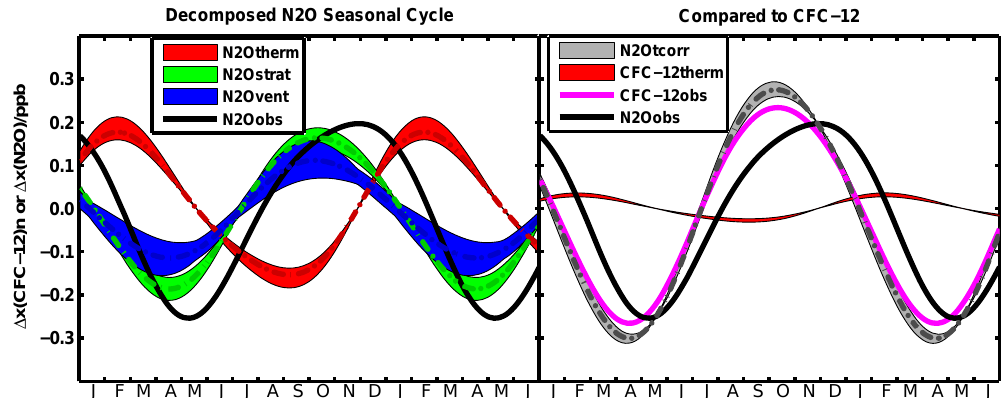
Fig. 12. (a) Decomposition of N 2 O seasonal cycle at Cape Grim based on methodology described in Nevison et al. (2005). Envelopes show estimated uncertainty in stratospheric and thermal signals, with the biological oceanic ventilation signal derived as a residual of observed N 2 O minus the thermal and stratospheric terms. Figure uses smoothed, idealized curves. (b) Comparison of observed CFC-12 seasonal cycle at Cape Grim to the observed N 2 O cycle, before and after correcting N 2 O for the thermal signal from (a) . The corresponding thermal signal in CFC-12 is small (red envelope) and does not substantially change the observed CFC-12 seasonal cycle. The observed and thermal CFC-12 curves are shown in ppb units, after being normalized by [ x (N 2 O)/ppb]/[ x